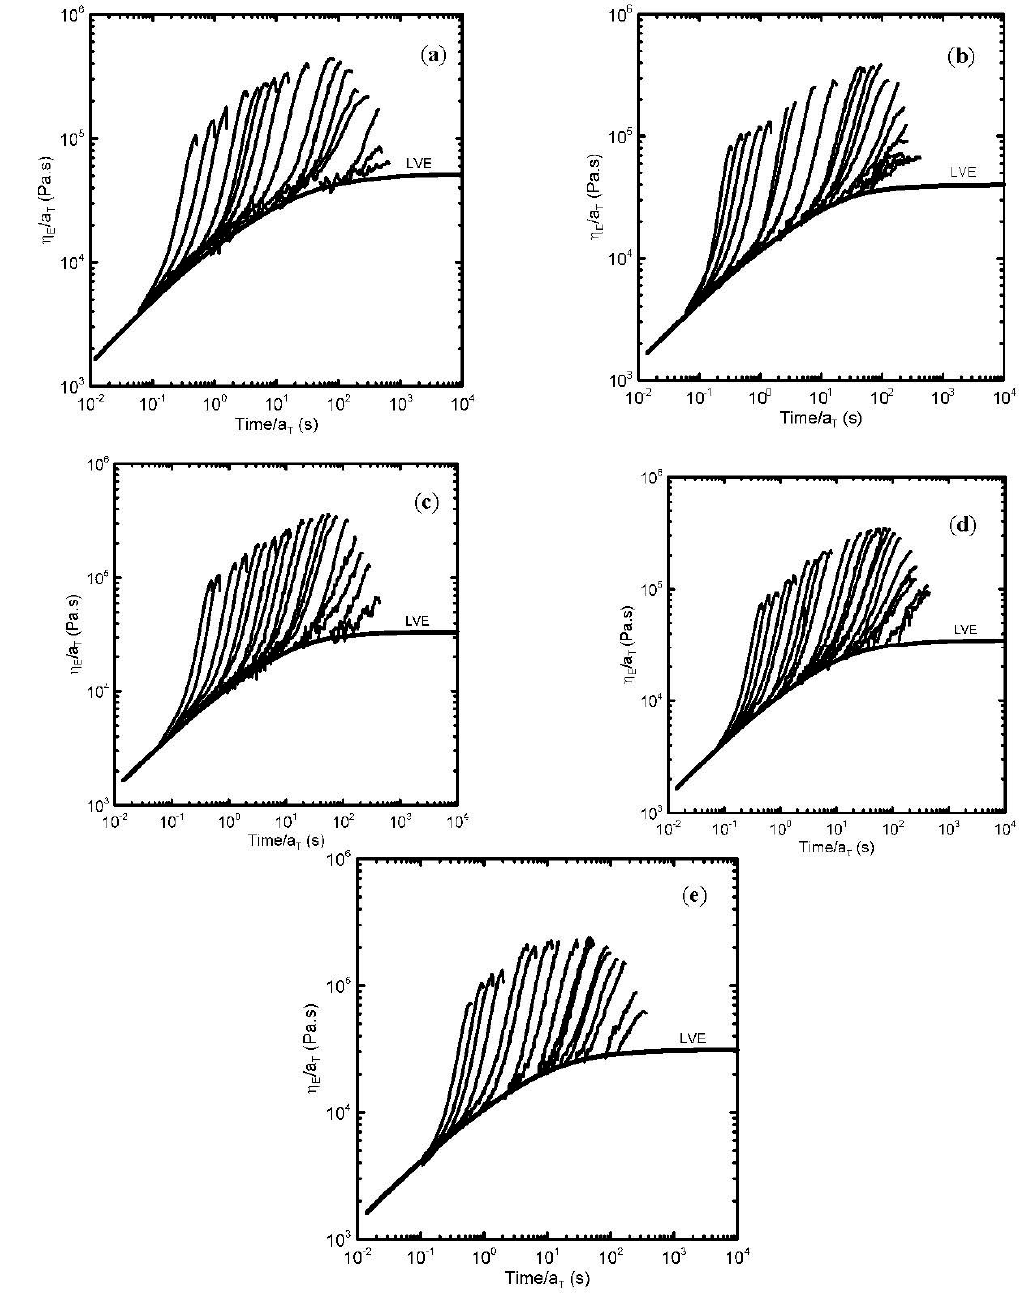
Figure 7. Transient extensional rheology of virgin as well as degraded branched polypropylene obtained from Sentmanat extensional rheometer at different extensional strain rates for 180 °C. ( a ) Virgin PP; ( b ) 1 h degraded PP; ( c ) 3 h degraded PP; ( d ) 5 h degraded PP; ( e ) 7 h degraded